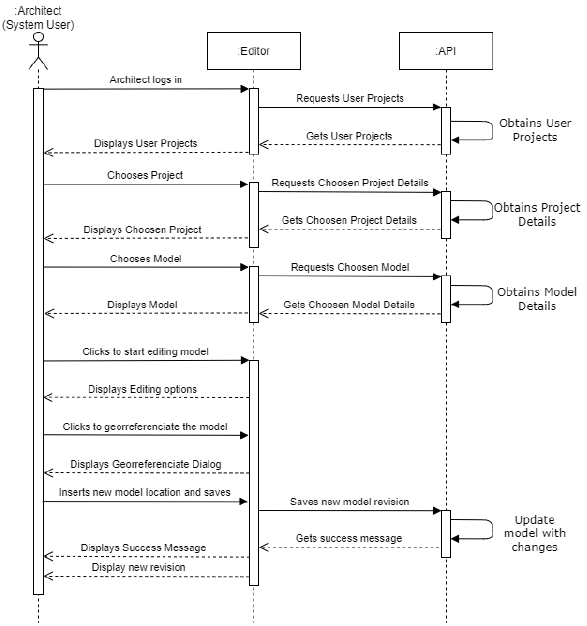
Figure 8. Sequence Diagram representing the process of georeferencing a 3D